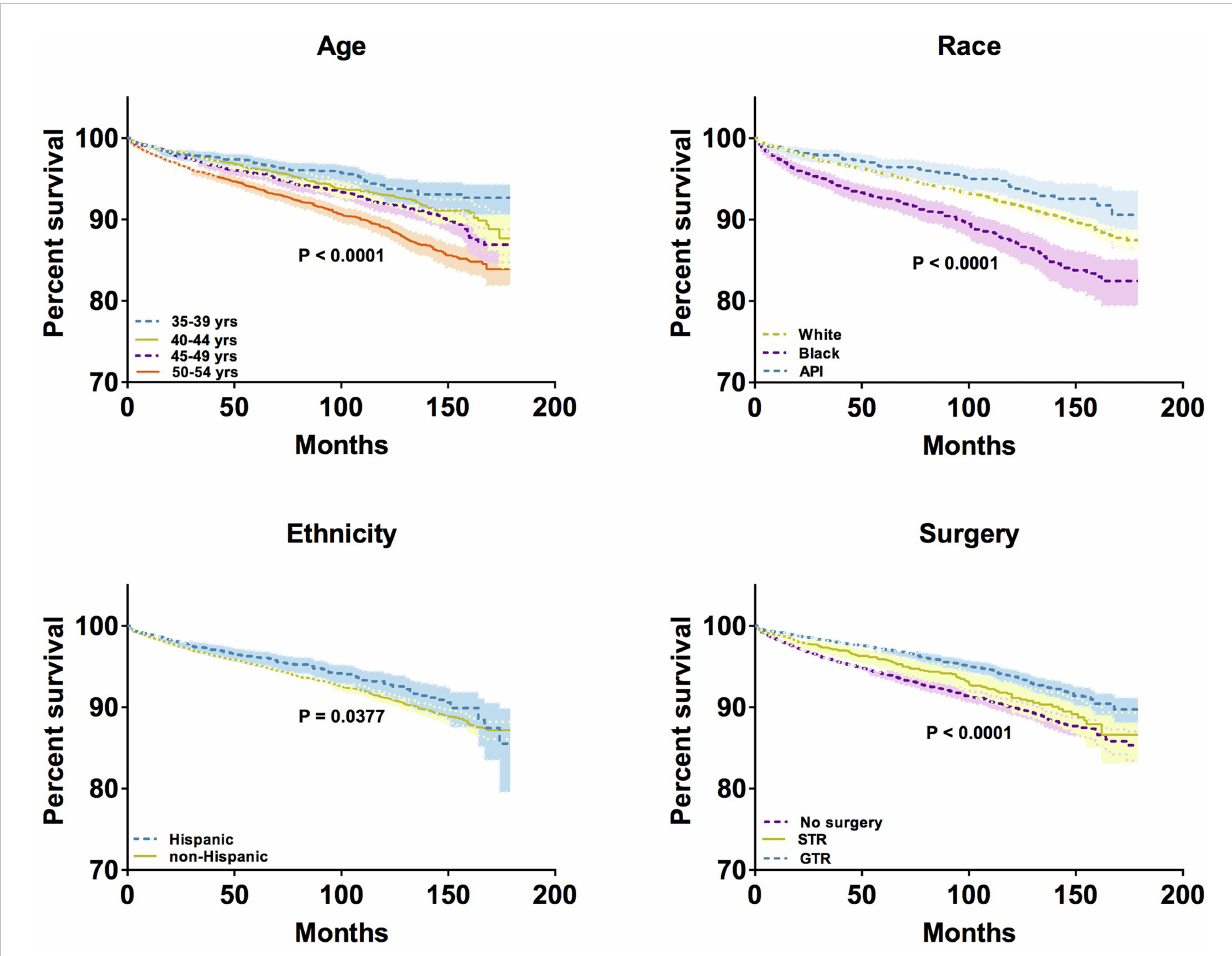
FIGURE 5 Kaplan – Meier analysis by age, race, ethnicity, and surgical treatment. * Only show signi fi cant differences in overall survival at the P < 0.05